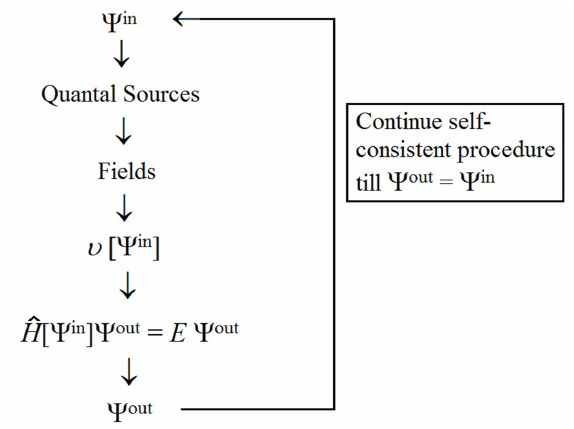
Figure 1. Self-consistent procedure for the solution of the Schrödinger